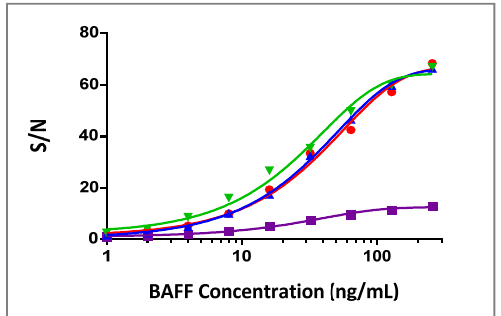
Figure 5. Response of COS-1/B2T.cl.17 to BAFF stimulation in serum matrix: BAFF dose response curves in 10% rat (red), 10% cynomolgus monkey (purple), 10% human (blue)